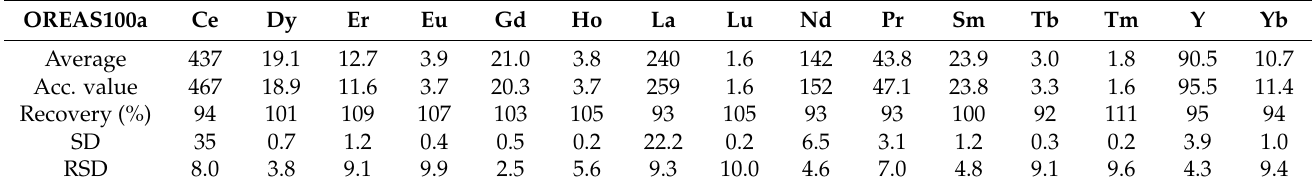
Table 8. Performance of the developed method on OREAS100a analysis in terms of accuracy and